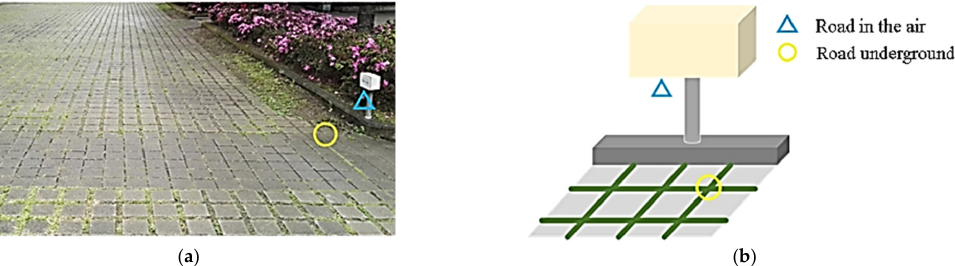
Table 3. Sensing positions on the pervious road.